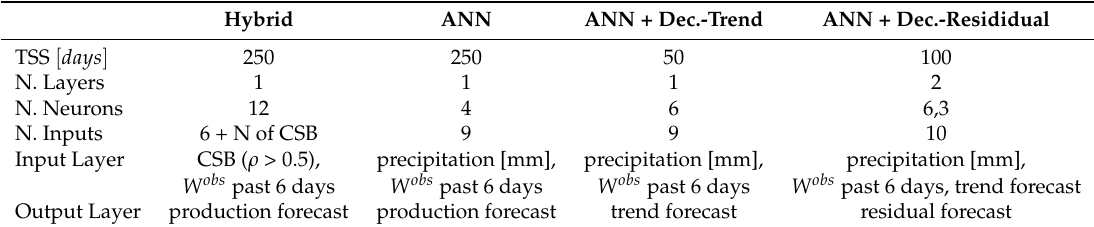
Table 2. Benchmark ANNs parameters settings: Hybrid, ANN, and ANNs with decomposition (Trend and Residual); TSS is the Training Set Size.